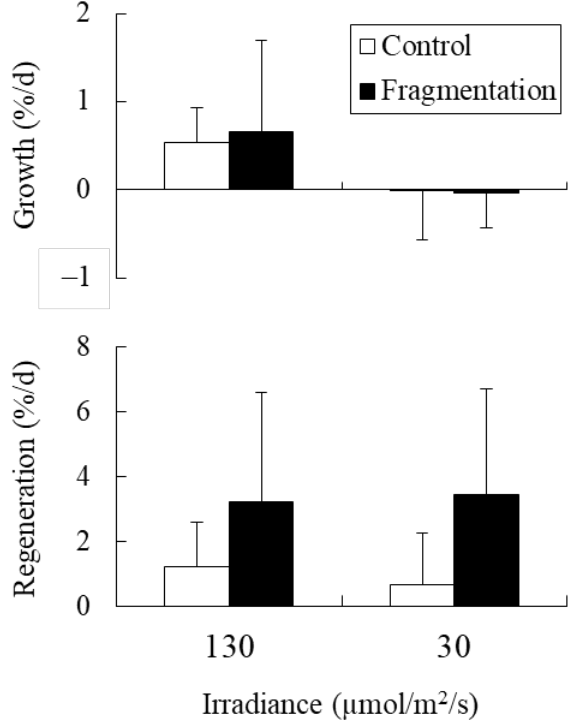
Figure 4. Relative growth and regeneration rates of Sargassum fusiforme holdfasts cultured in eight